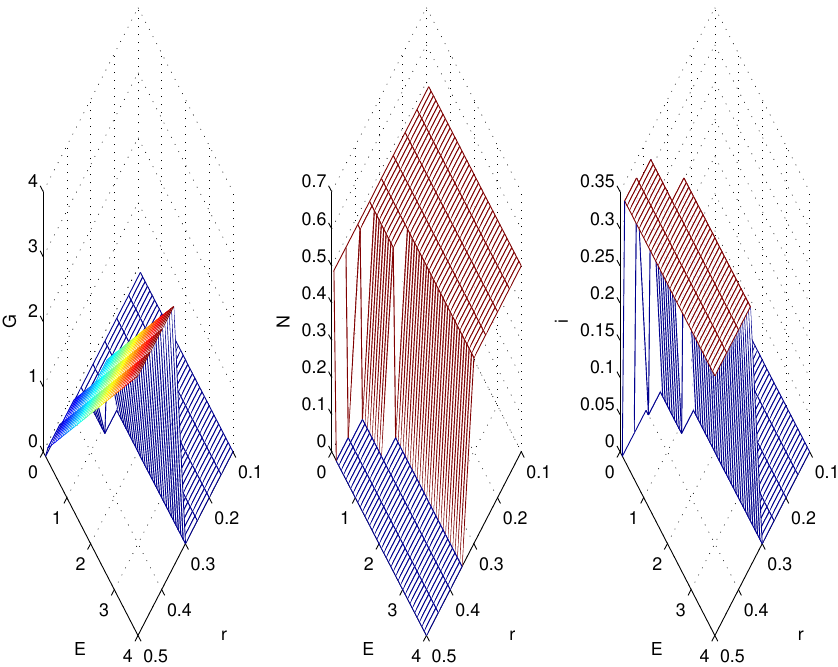
Figure 8. Simulation with µ = 10.0. Now, the red squirrels survive also for small E , at higher values. Disease prevalence is very much reduced; compare the right plot’s vertical scale of each